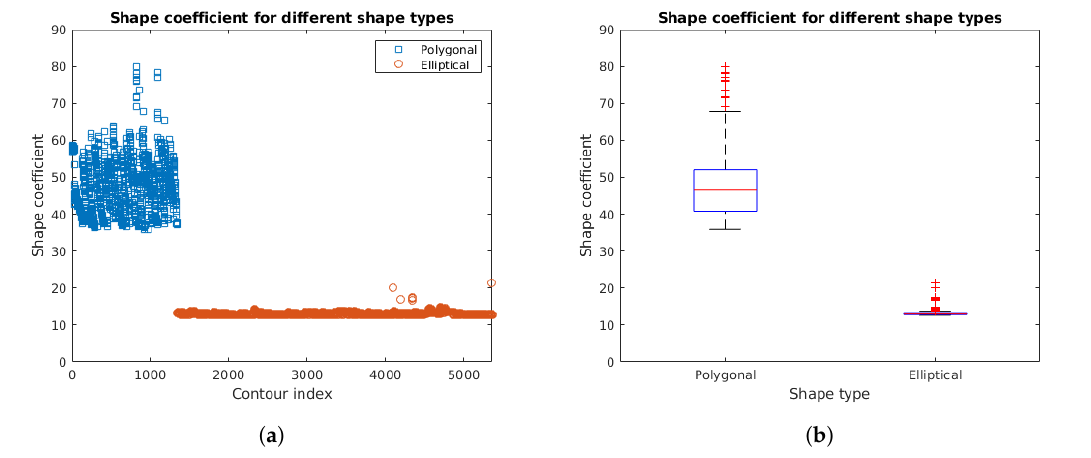
Figure 9. Shape coefficient presented in Equation (1) for different shape types: ( a ) results for individual contours; and ( b ) statistics of the combined